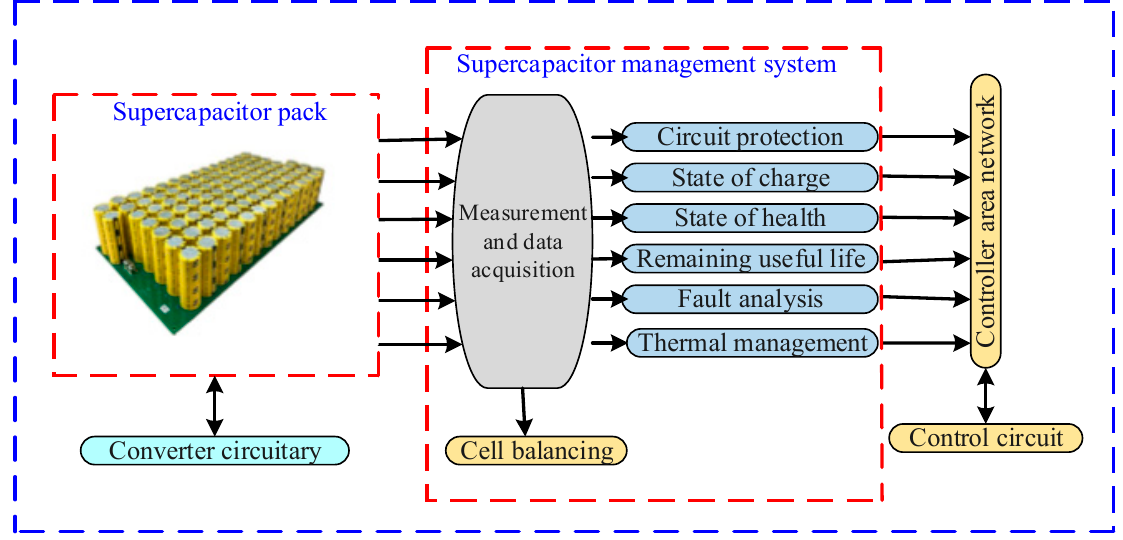
Figure 1. Schematic diagram of SOC, SOH, and RUL estimation in